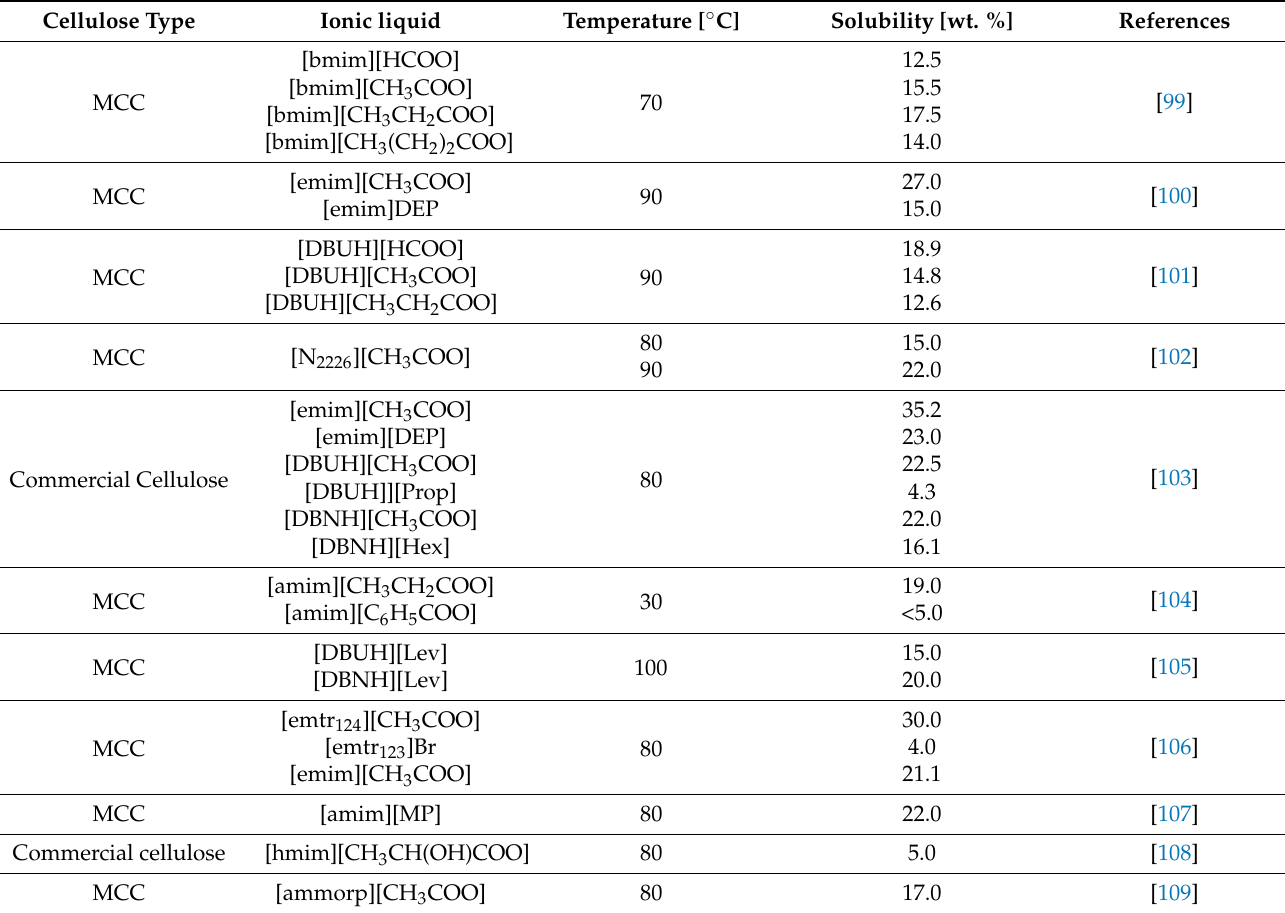
Table 3. Cellulose solubility in ionic